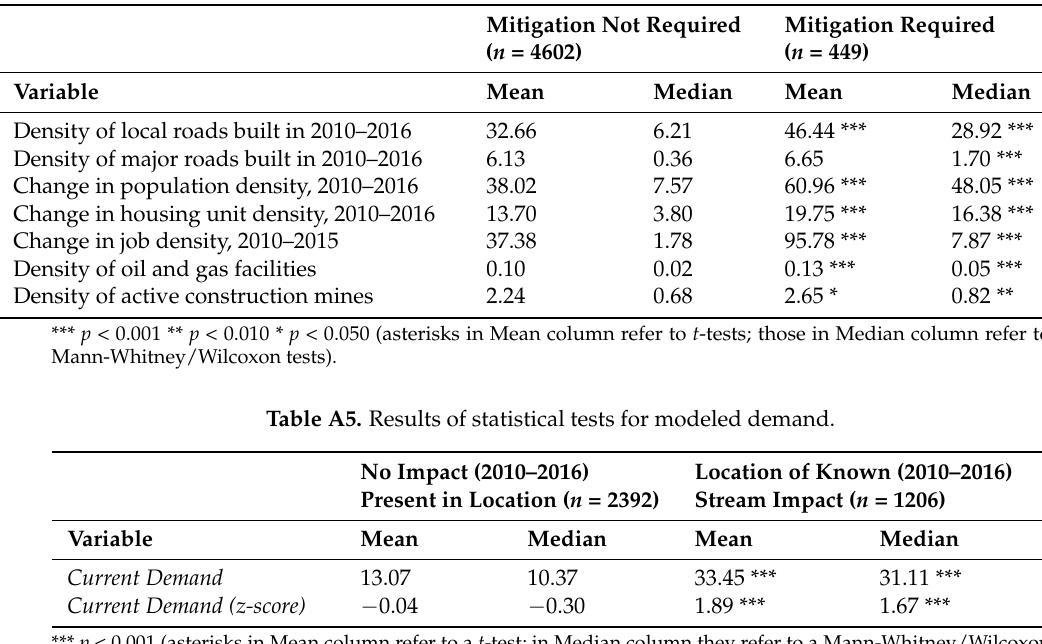
Table A4. Results of statistical tests for development variables.